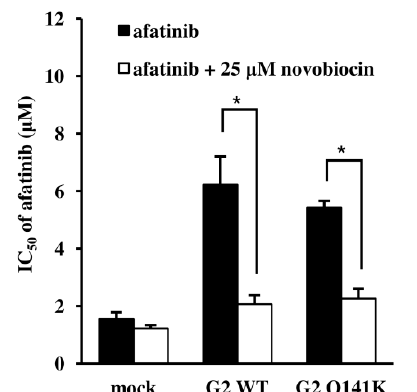
Figure 3. Transport of afatinib by ABCG2. The viability of Flp-In-293/mock cells, Flp-In-293/ABCG2 WT cells, and Flp-In-293/ABCG2 Q141K cells was evaluated by the MTT assay after incubation with afatinib alone or afatinib combined with 25 μ M novobiocin for 72 h. P-values were determined by Student’s t test (* P < 0.01). Data are expressed as the mean ± SD. Each experiment was repeated three times.